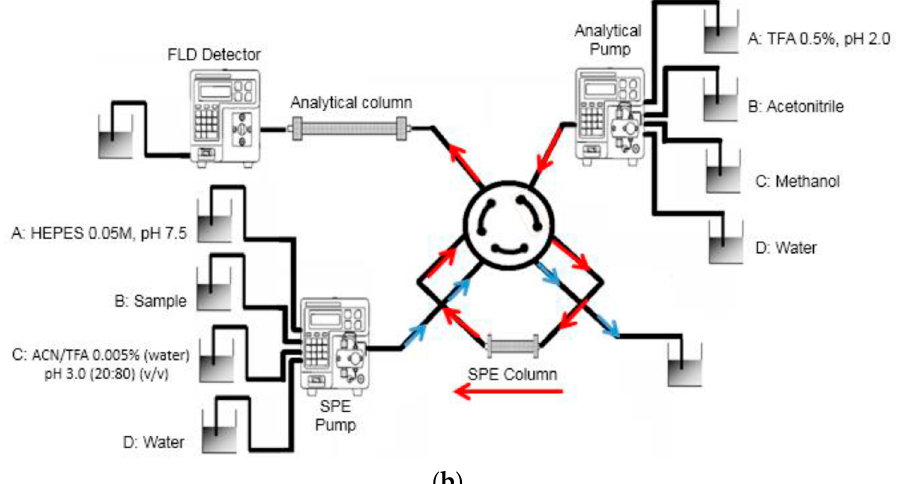
Figure 9. Scheme of the online MISPE-HPLC setup: ( a ) valve position A—sample loading; ( b ) valve position B—sample analysis. Reprinted from [31], with permission from Open Access MDPI, 2022.